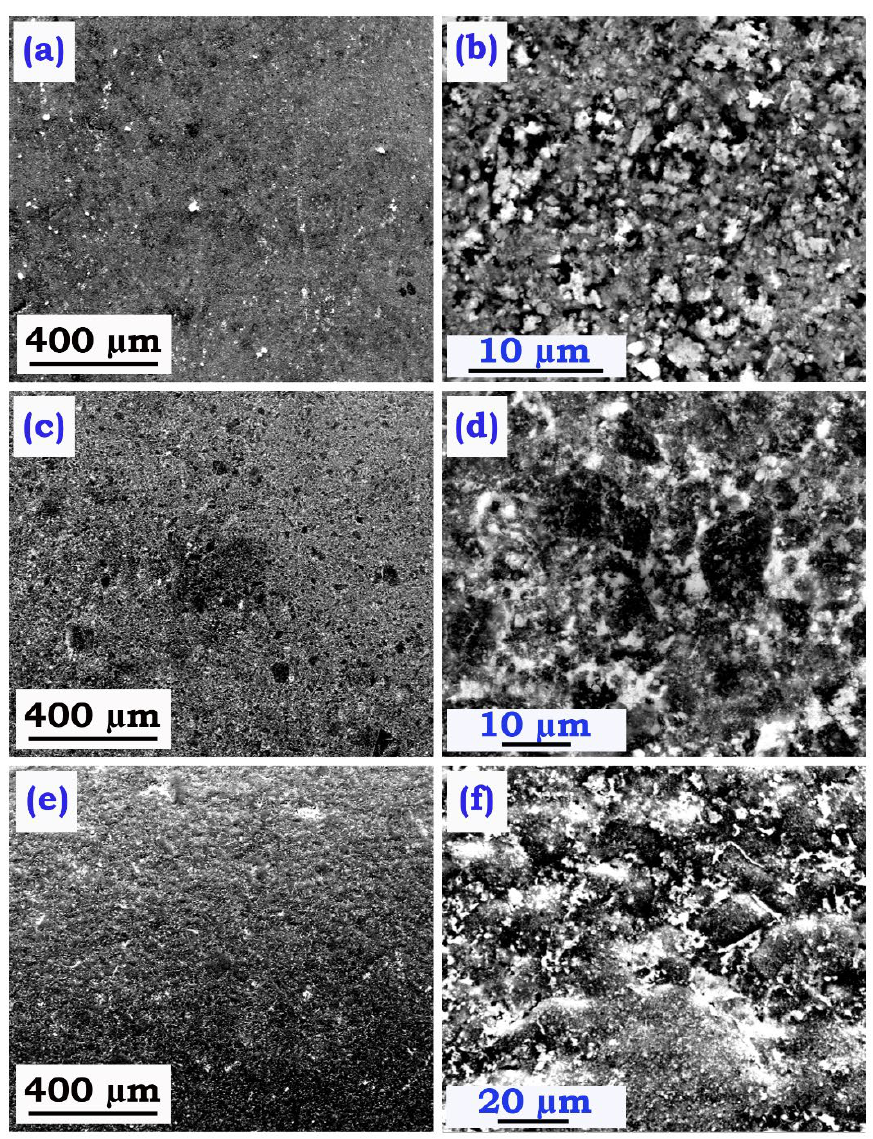
Figure 6. SEM micrograph of ( a , b ) IQC-10Sn-PS, ( c , d ) IQC-20Sn-PS, ( e , f ) IQC-30Sn-PS pressureless- sintered at 800 °C (1073 K) for 10 h at different magnifications.